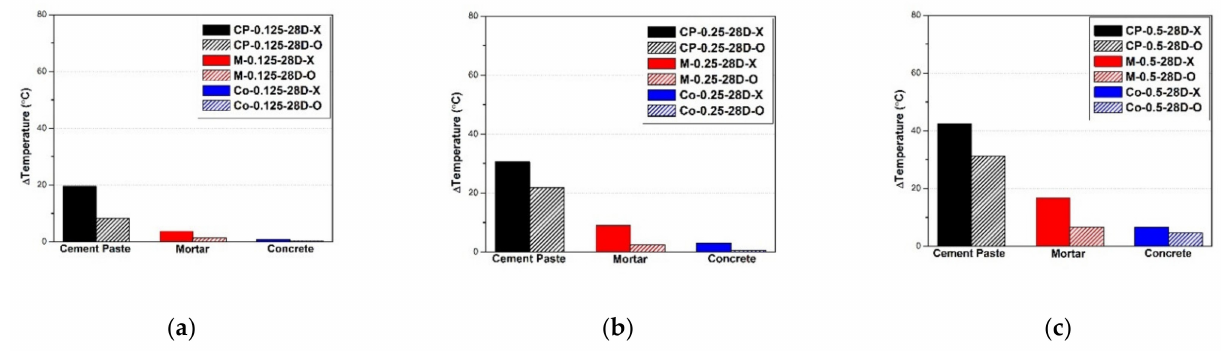
Figure 6. Temperature variations by voltage supply at 28 curing days: ( a ) 0.125 wt%, ( b ) 0.25 wt%, and ( c ) 0.5